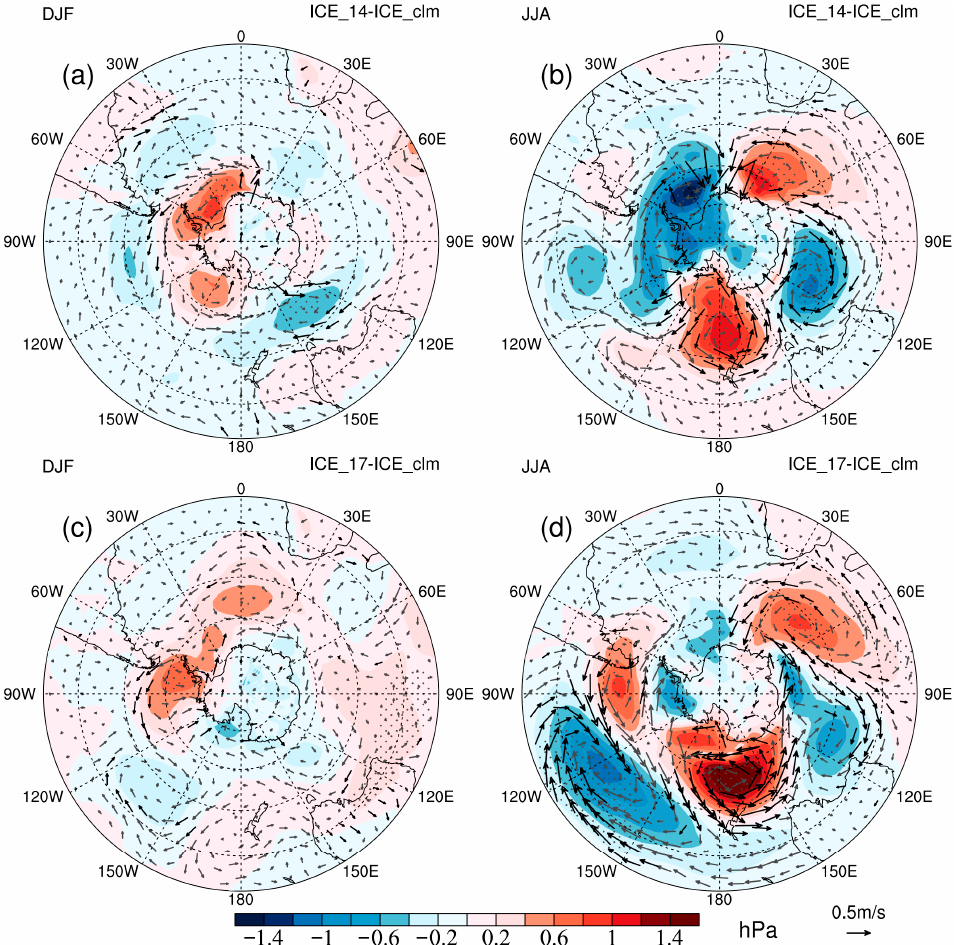
Figure 5. Changes in the sea-level pressure and near-surface winds as a result of changes in Antarctic sea ice. Differences between ICE_14 and ICE_clm in ( a ) summer and ( b ) in winter. Differences between ICE_17 and ICE_clm in ( c ) summer and ( d ) winter. The dotted areas were statistically significant at the 95% confidence level. The contours represent the mean state of ICE_clm.